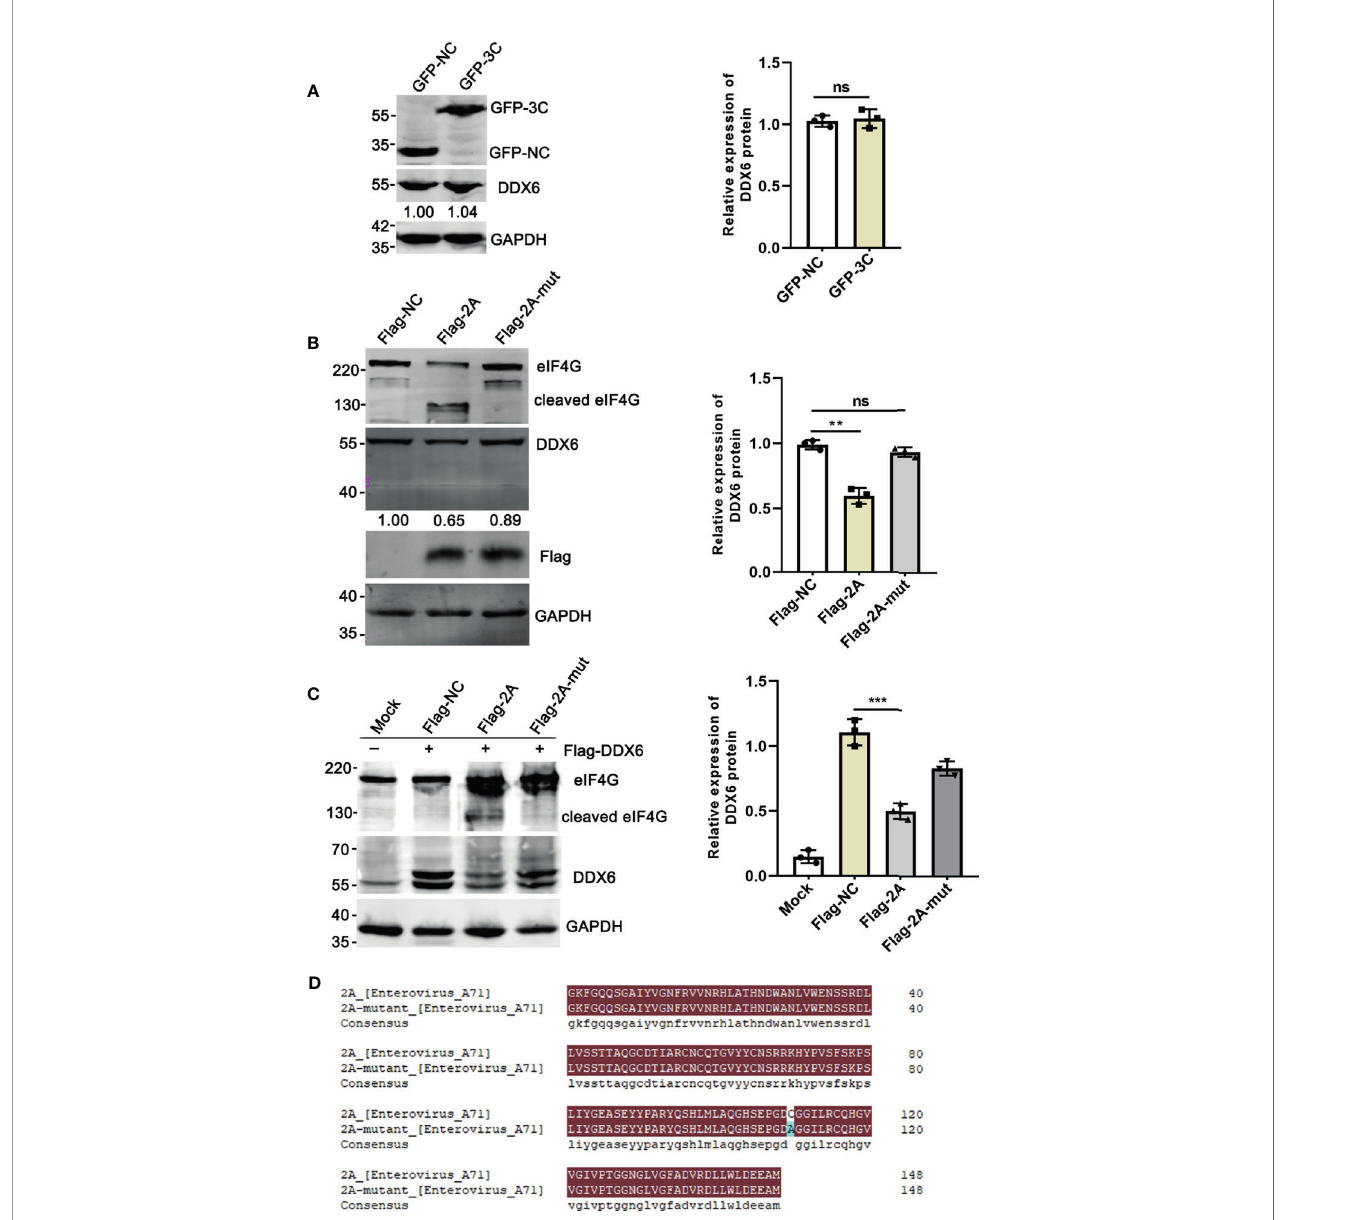
FIGURE 6 | The endogenous DDX6 was degraded by viral-2A pro but not 3C pro . (A) HeLa cells were transfected with an empty vector (pEGFP-C1) or plasmid encoding EV71 protease 3C for 36 h. The whole-cell lysate was analyzed by immunoblotting using speci fi c antibodies (GAPDH, DDX6, and GFP). (B) HeLa cells were cultured in 6-well dishes, transfected with equal amounts of Flag-NC, Flag-2A, and Flag-2A-mutant (2500 ng), respectively. The cells were lysed and analyzed by Western blot. (C) 293T cells transfected with Flag-DDX6 and then transfected with equal amounts of Flag-NC, Flag-2A, or Flag-2A-mutant plasmids for 24 h, respectively. Western blot was performed using various speci fi c antibodies (eIF4G, DDX6, and GAPDH) (**P < 0.01; ***P < 0.001, ns indicate no signi fi cant difference). (D) The plasmid encoding 2A-mutant was constructed by mutating the amino acid at the 110 th position of the wild-type 2A, and the amino acid comparison diagram of wild-type and mutant 2A was produced by